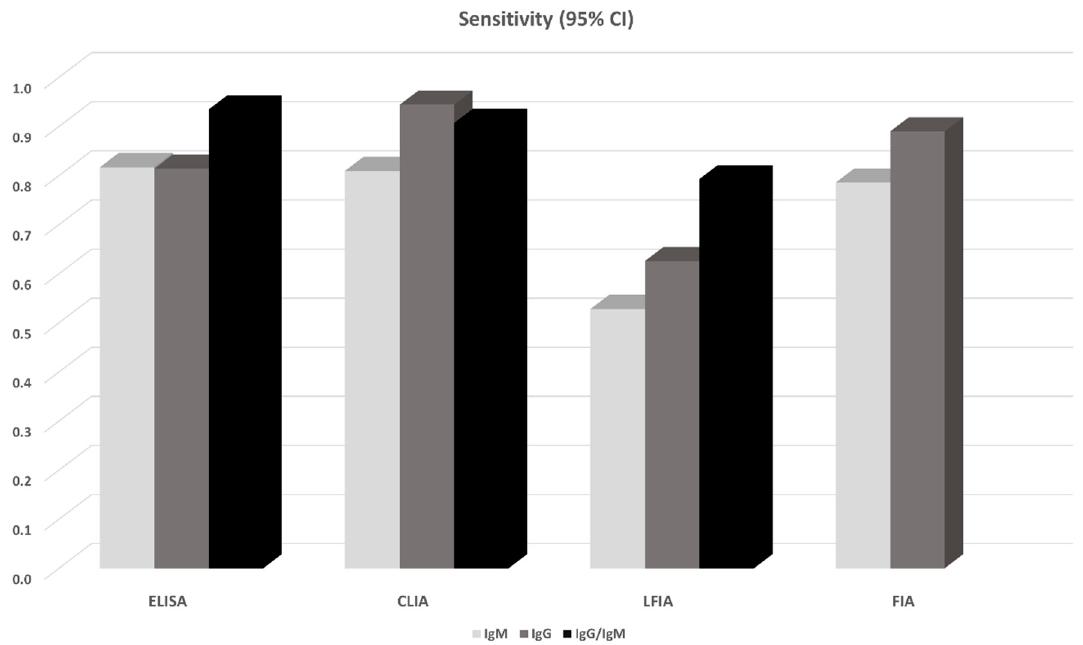
Figure 2. Pooled sensitivity of antibody tests obtained from meta-analysis. For the details see Table 2 and the Results section.